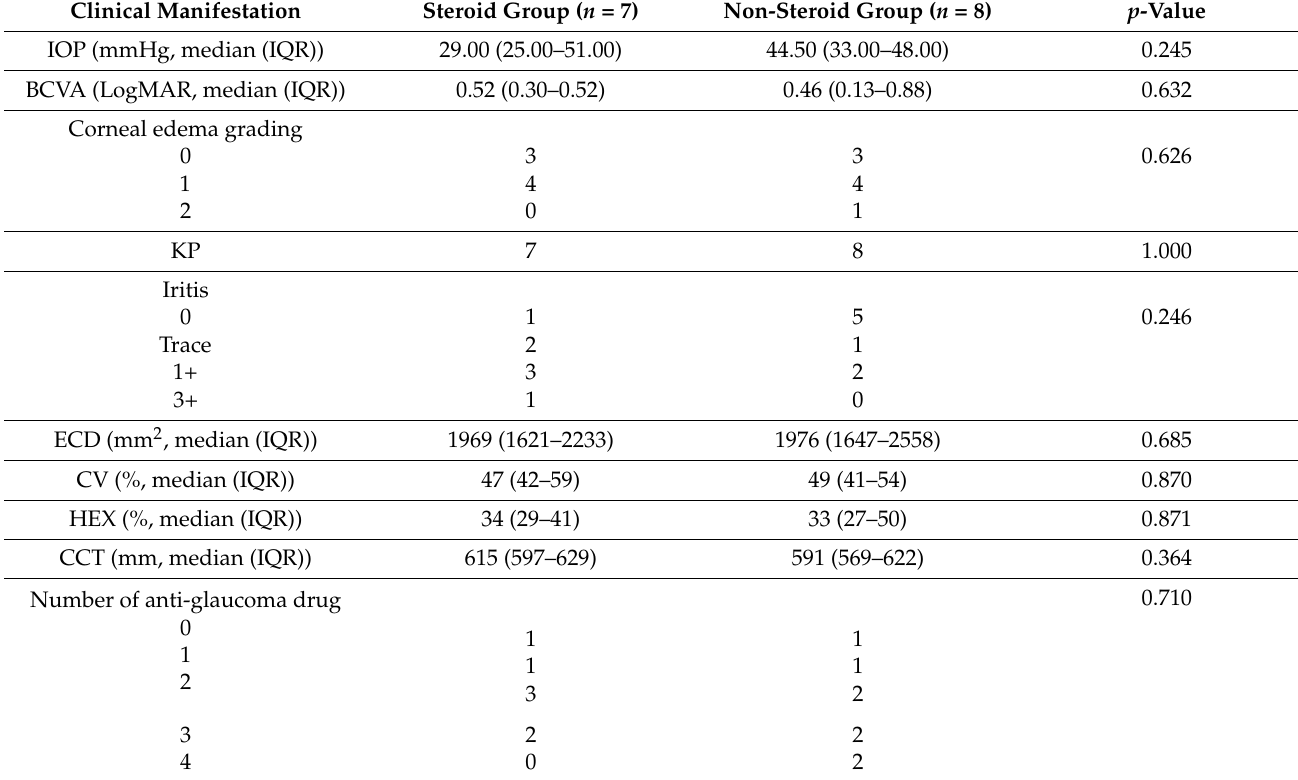
Table 2. The Difference of Initial Clinical Manifestation Between the Steroid Subgroup and Non- steroid Subgroup.